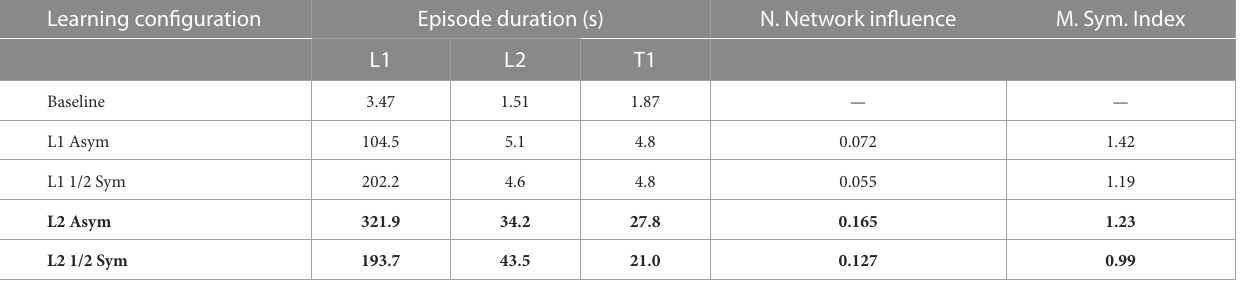
TABLE2 Statisticalaveragedurationofresistingrandomforceperturbations(500 N–850 N,impulse12.5–20 N s)indifferentlearningconfigurations.